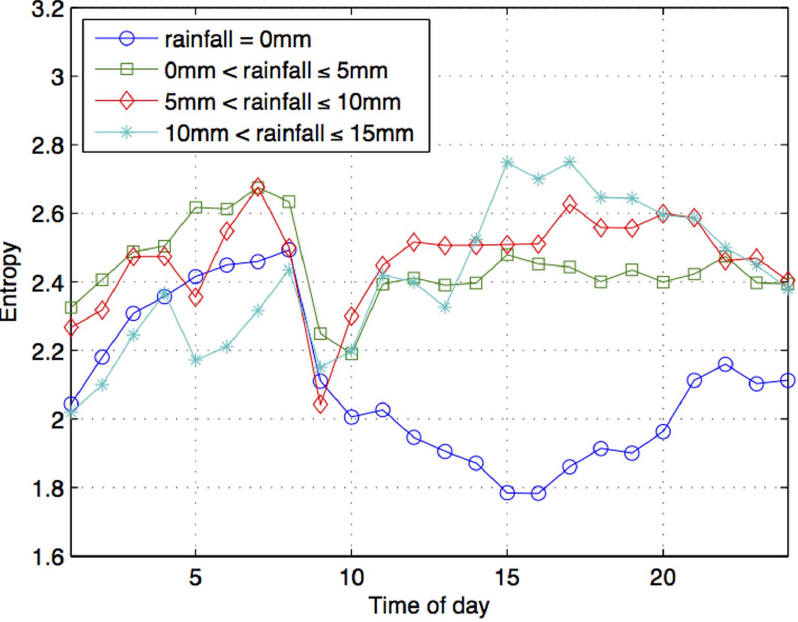
Figure 13. Entropy values across time of the day under different bands of rainfall.